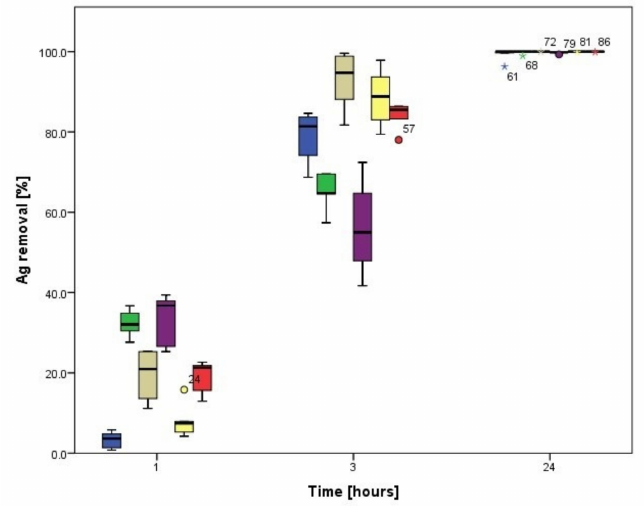
Figure 2. Ag removal by 0.050 g (wet weight) of Aspergillus tabacinus pellets at different pH values and contact times. pH: (cid:4) : 2; (cid:4) : 3; (cid:4) : 4; (cid:4) : 5; (cid:4) : 6; (cid:4) :